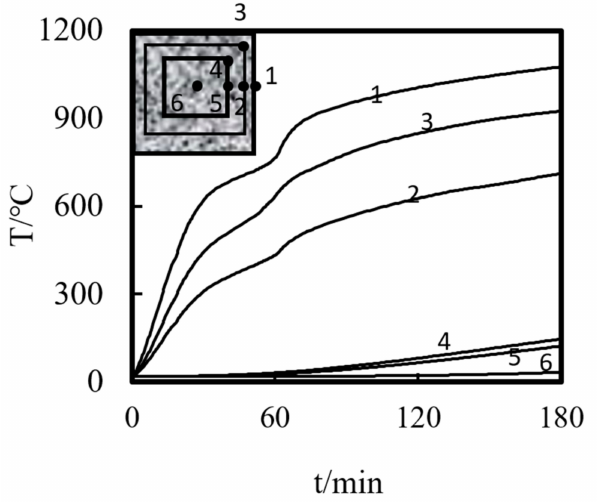
Figure 6. Temperature time–curve of each point in the